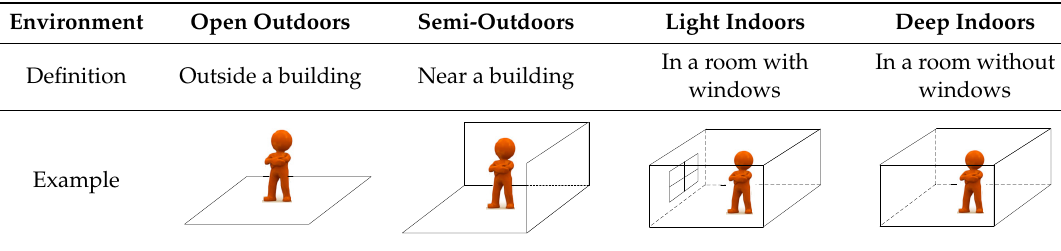
Table 1. Four indoor/outdoor environments.